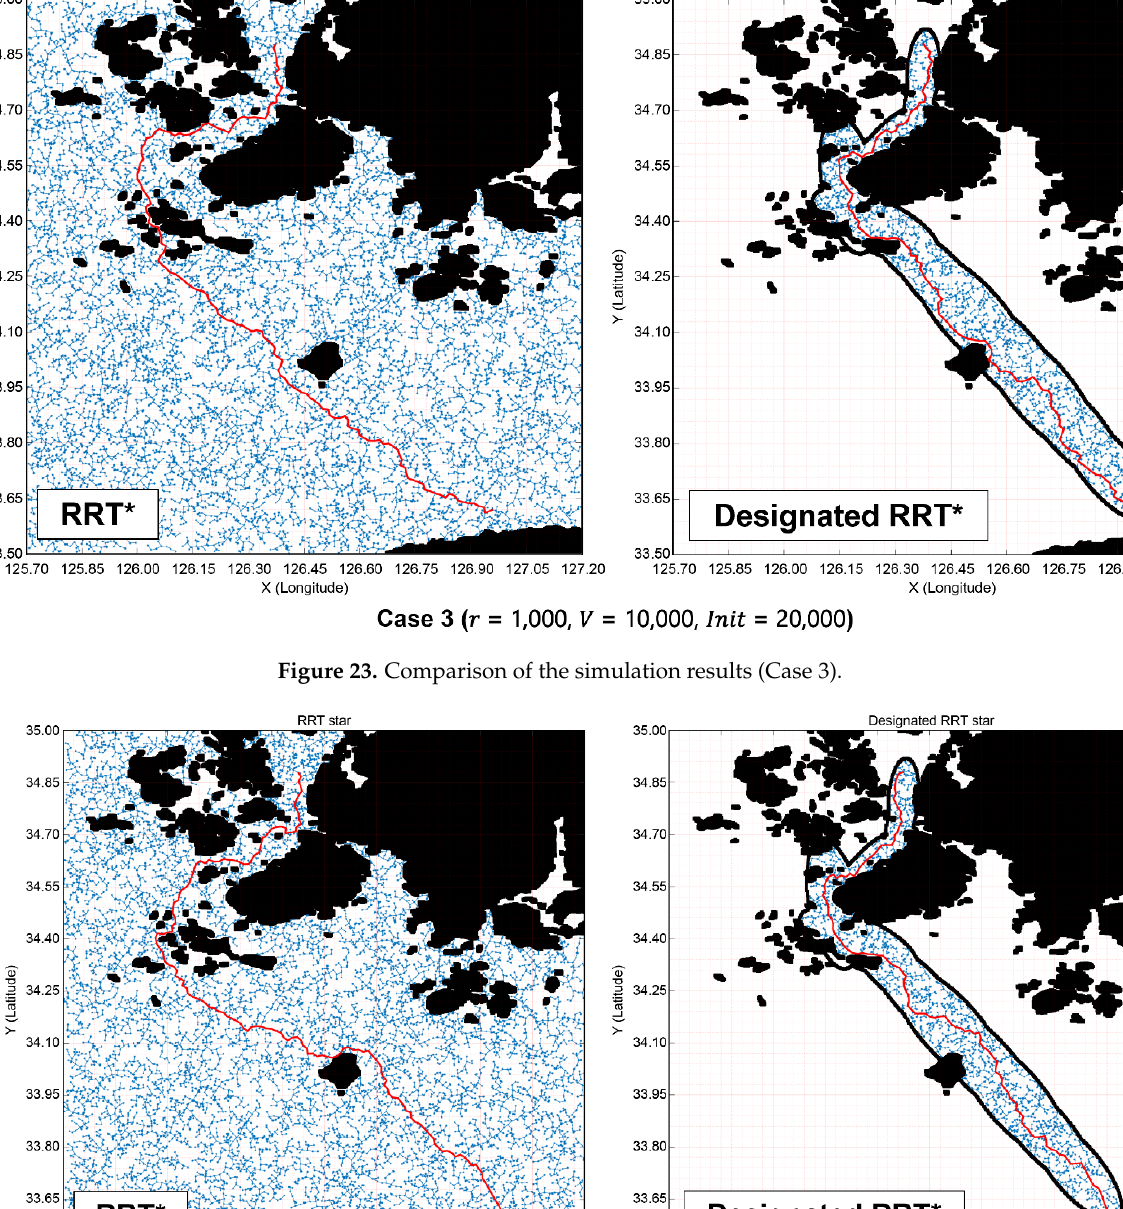
Figure 24. Comparison of the simulation results (Case 4).